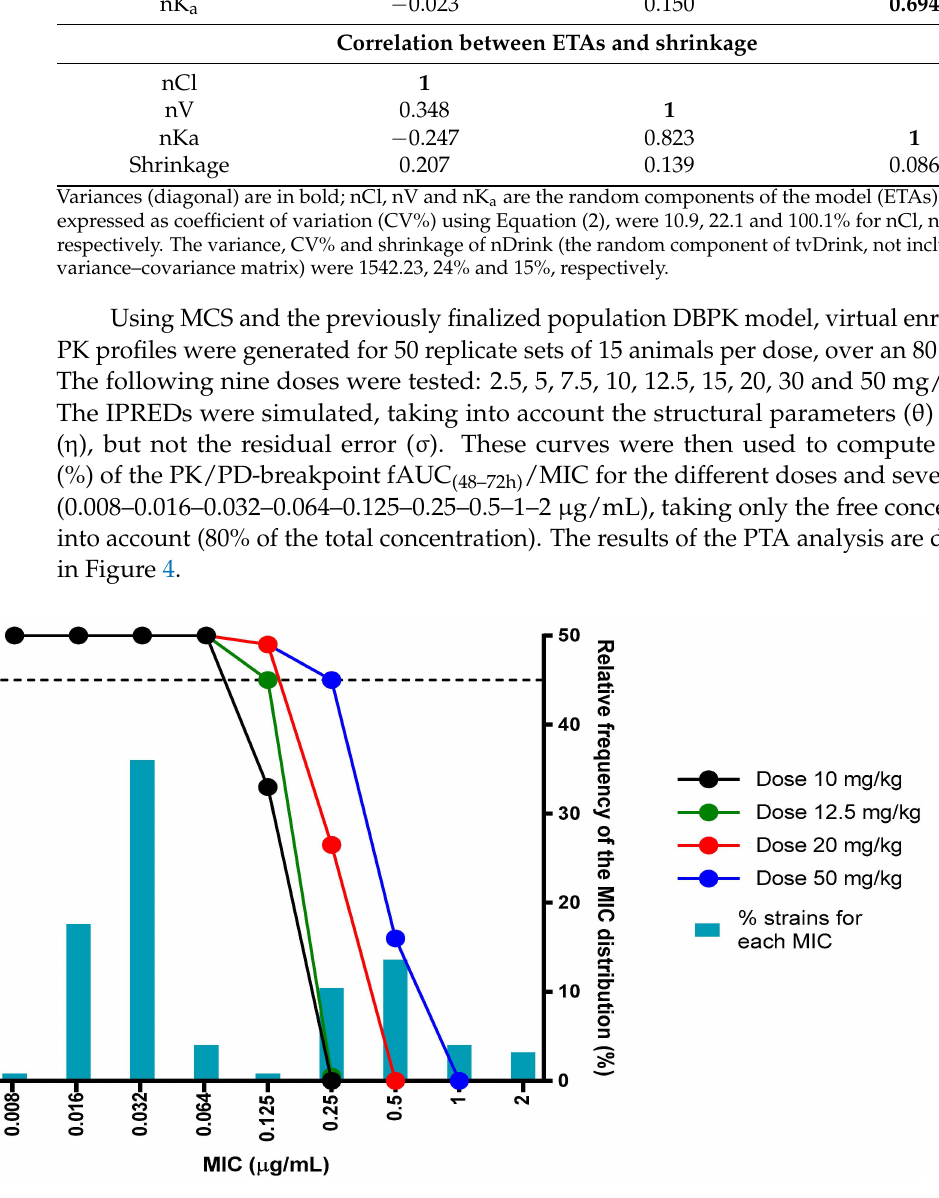
Figure 4. Probability of target attainment (PTA) for fAUC (48–72 h)/MIC ≥ 100 h in 75 simulated broiler chickens for four doses of enrofloxacin (10, 12.5, 20 and 50 mg/kg) administered via drinking water (five other simulated doses are omitted). The horizontal dotted line signifies the PTA of 90%. The relative frequency of the MIC distribution of APEC strains is taken from a recent study from Flanders (Belgium) [24].